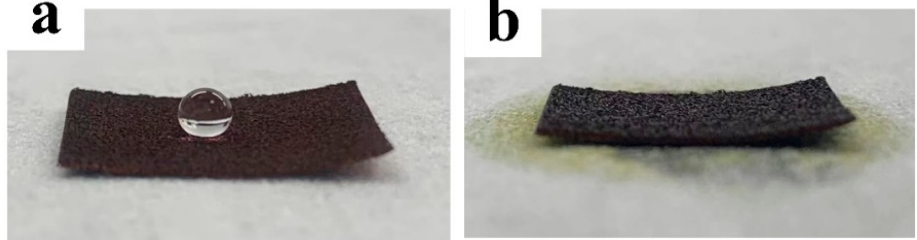
Figure 7. ( a ) Water droplet and ( b ) oil droplet on the laser-heat treated Cu foam indicating its su- perhydrophobicity/superoleophilicity.